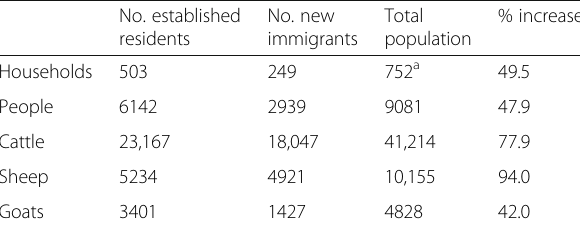
Table 1 New immigrants and previously established residents in 2011